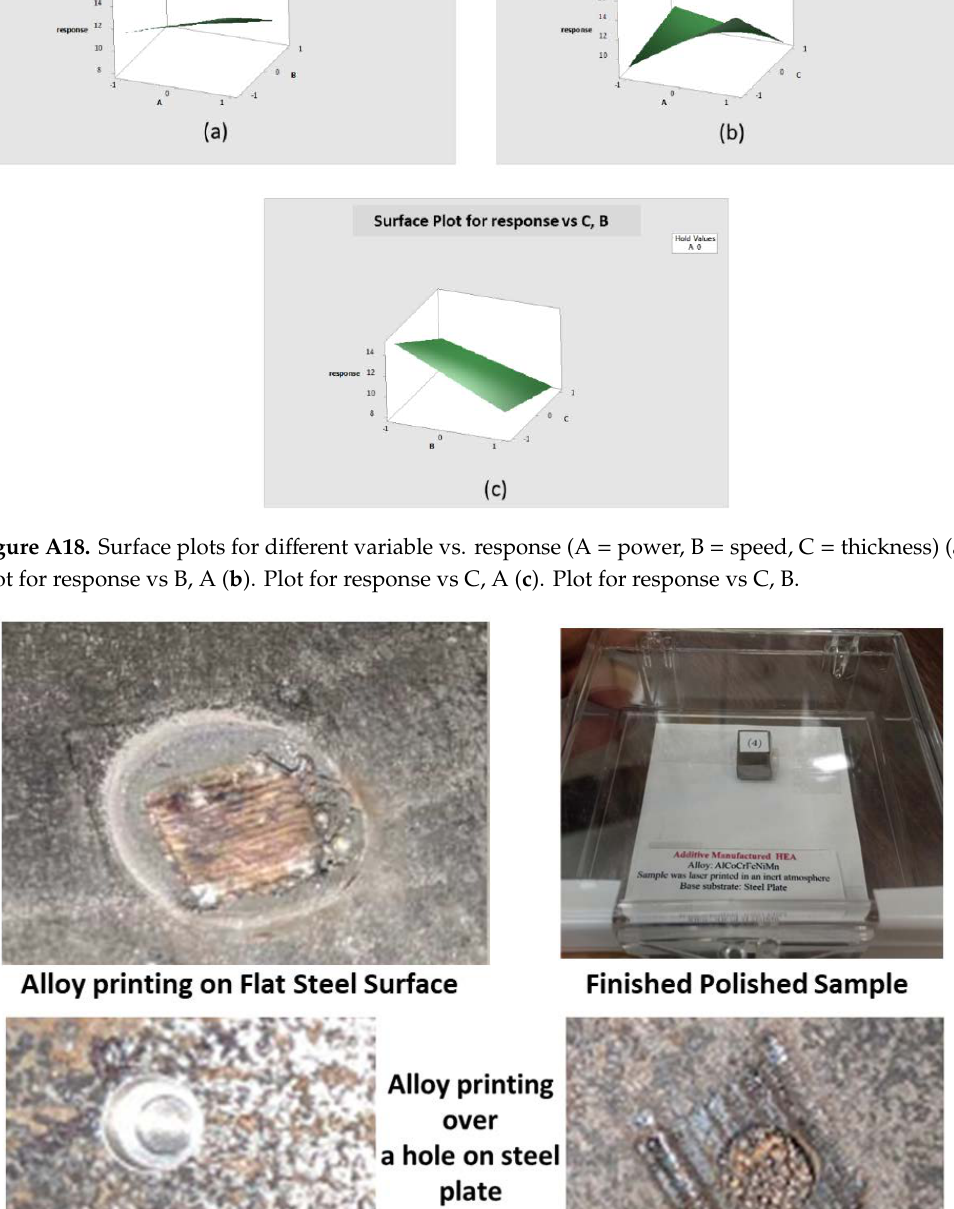
Figure A19. Alloy deposition (three layers) after optimization of various parameters.